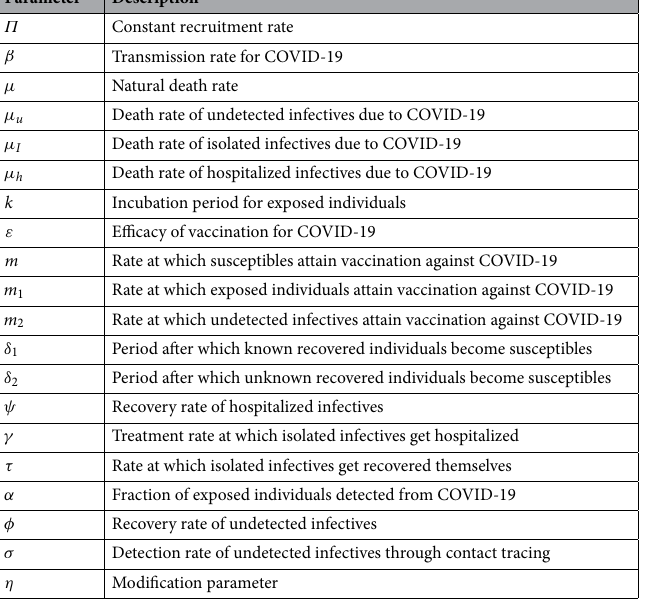
Table 2. The description of